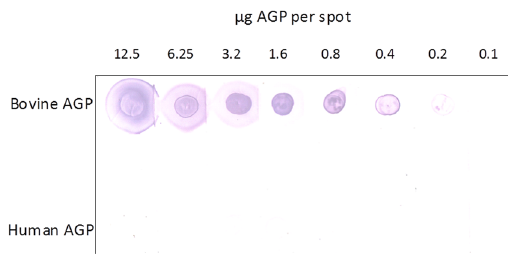
Figure 4. Lectin overlay assay. Binding of SubB Δ S106/ Δ T107 to serial dilutions of human or bovine AGP spotted onto nitrocellulose (total amounts of protein per spot indicated), was determined as described in the Materials and